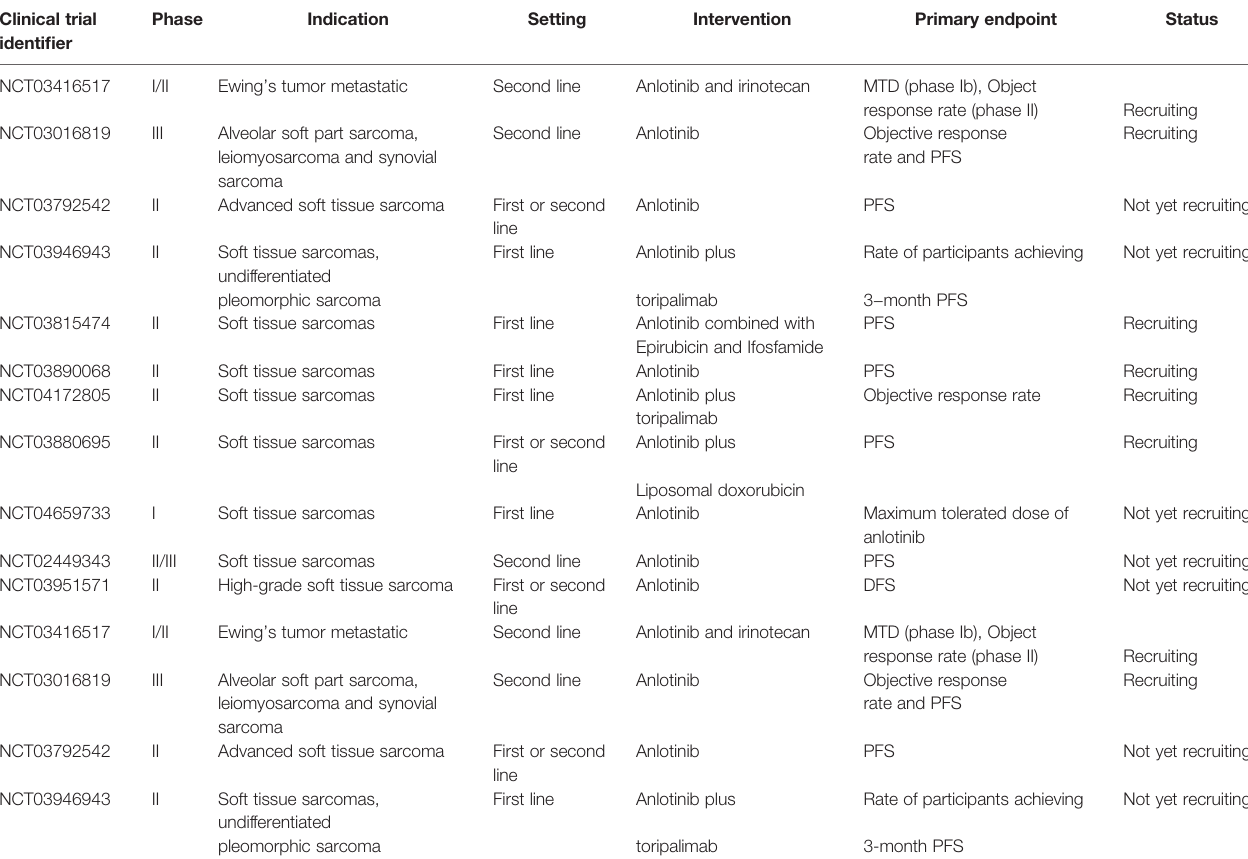
TABLE 3 | Selected ongoing trials of anlotinib in sarcoma treatment. Clinical trial identi fi